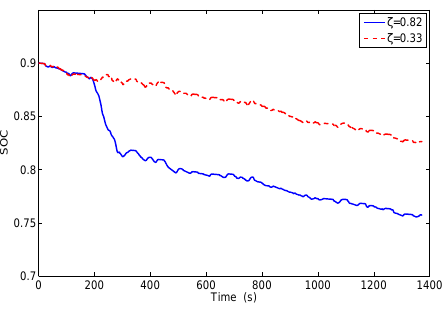
Figure 14. Battery SOC: ζ = 0 . 82 vs . ζ = 0 . 33 .